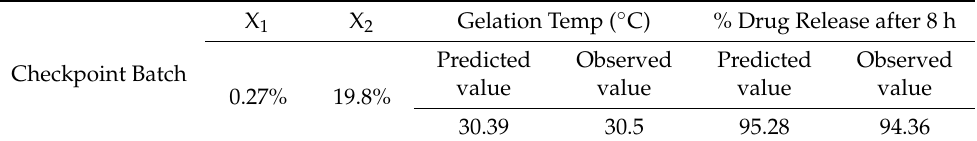
Table 4. Composition of checkpoint batch along with predicted and observed values.